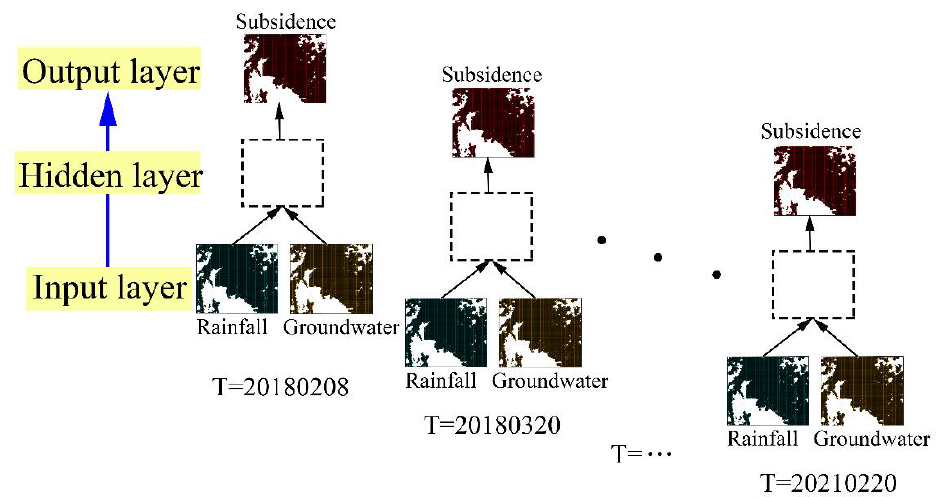
Figure 7. The constructed multi-factorial LSTM prediction model.